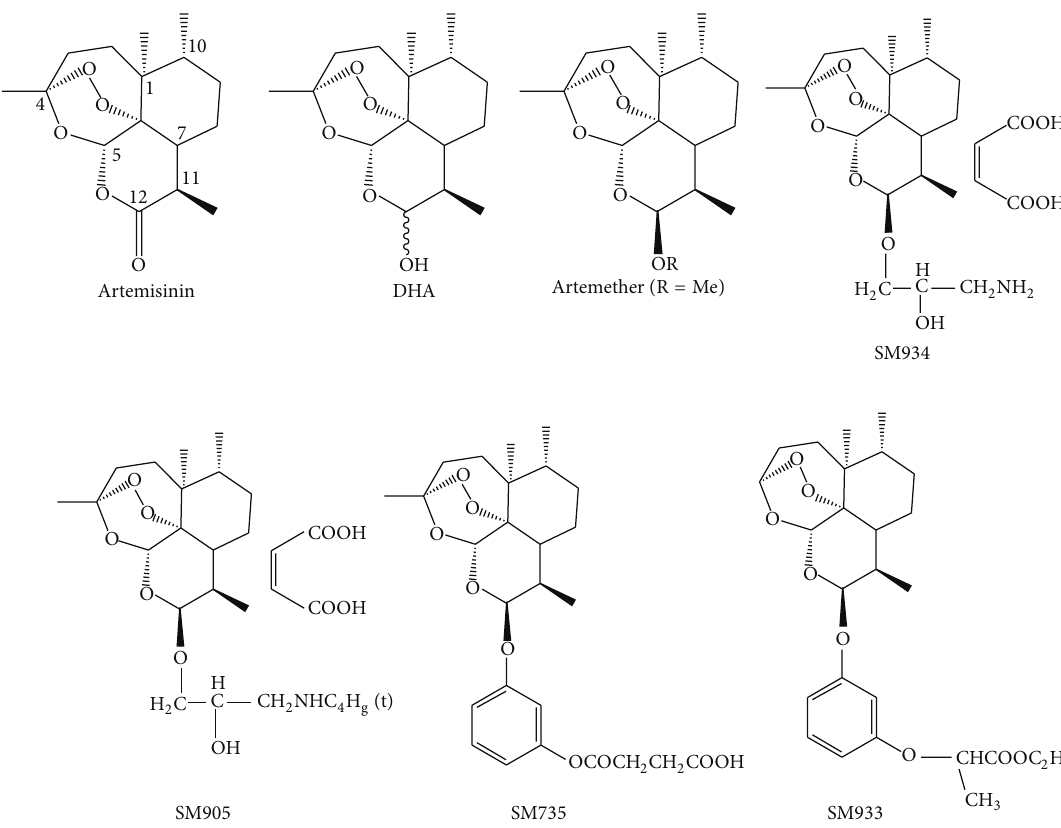
Figure 1: Chemical structure of artemisinin and its